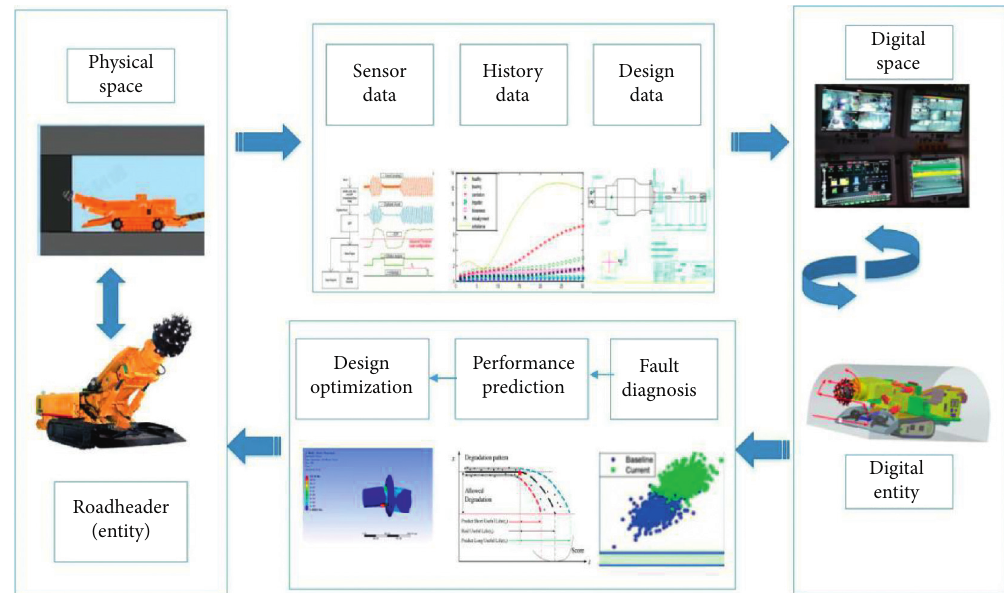
Figure 1: Application of digital twin technology in operation and maintenance of the